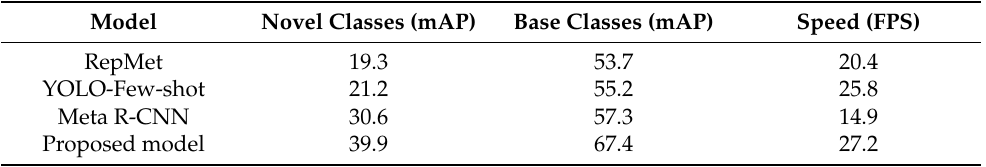
Table 2. Performance comparison between our proposed model and other state-of-the-art few-shot methods. Input image size is 640 × 640 and predictions are measured at 0.5 IoU metric.